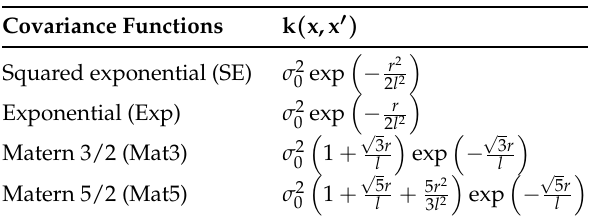
Table 1. List of stationary covariance functions. r = (cid:107) x − x (cid:48) (cid:107)